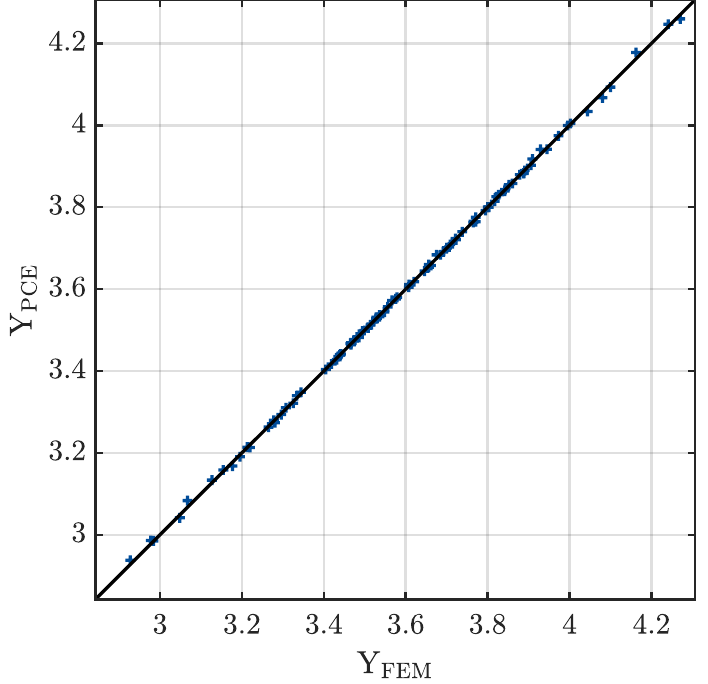
Figure 6. Critical buckling pressure obtained by the finite element method Y FEM and PCE prediction Y PCE .